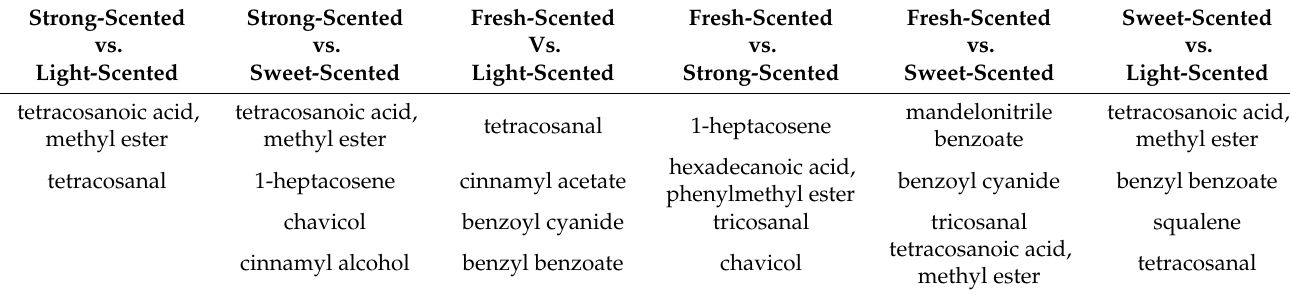
Table 2. Endogenous biomarkers for the identification of P. mume cultivars with four aroma